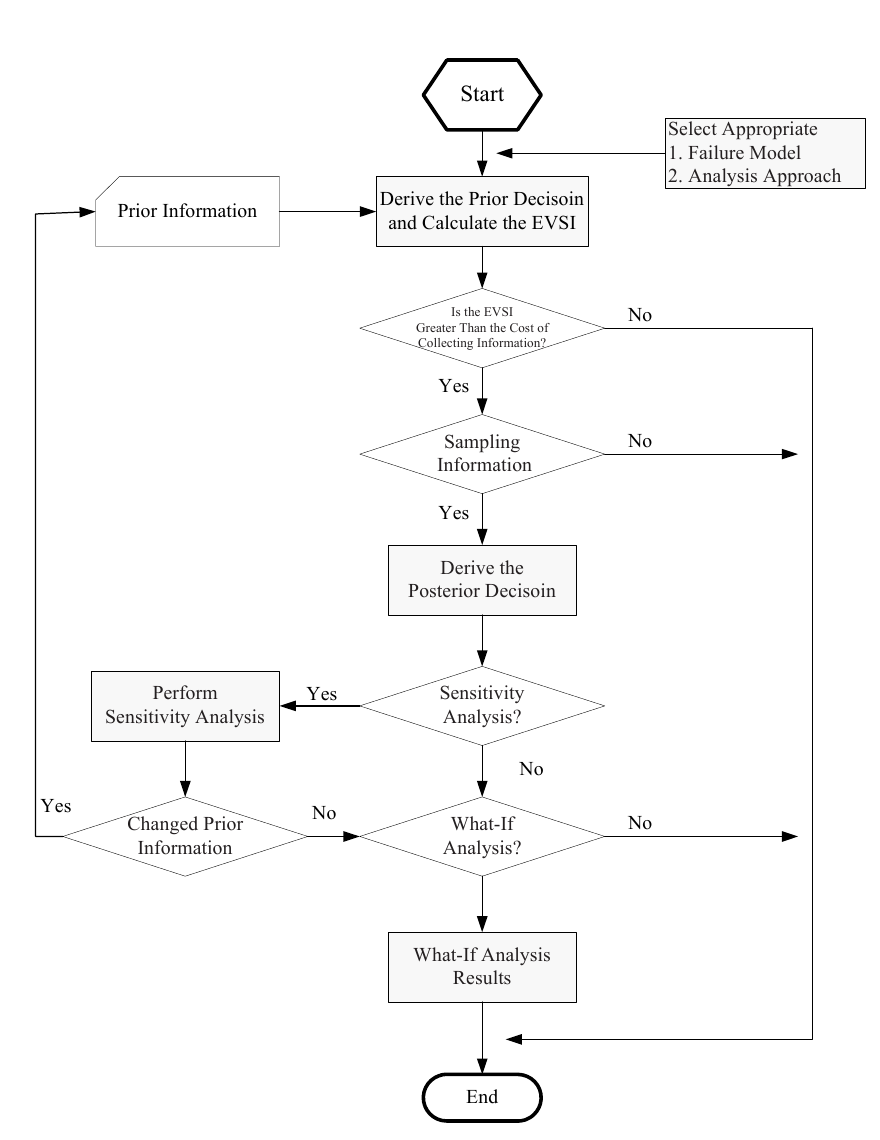
Fig. 1 The flowchart of